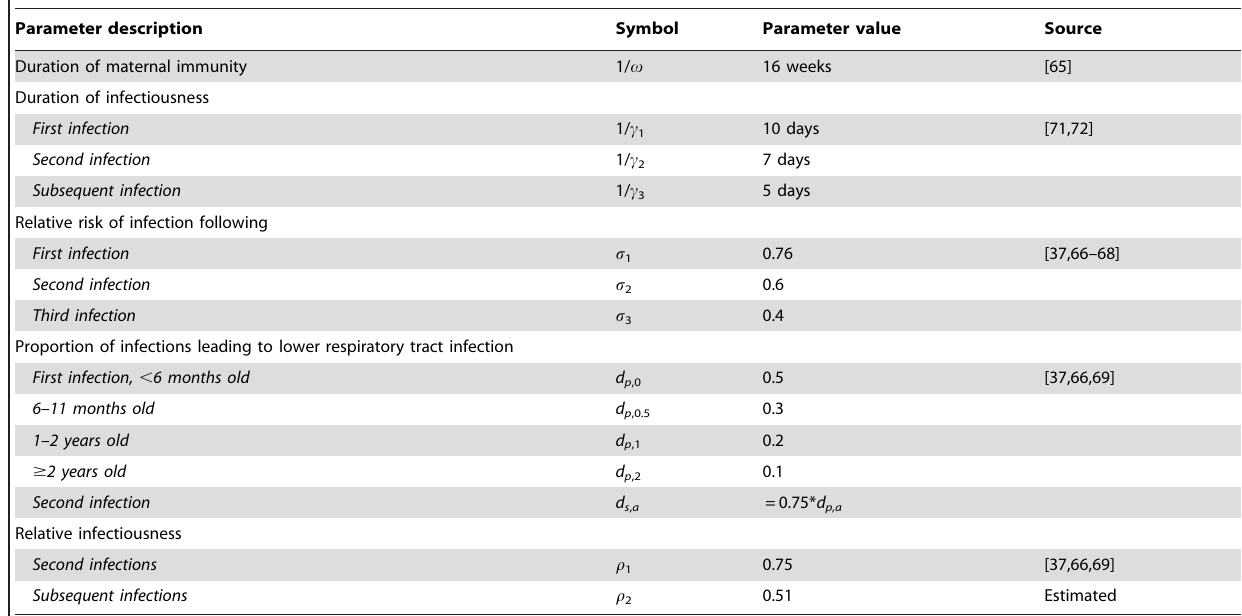
Table 2. Transmission dynamic model